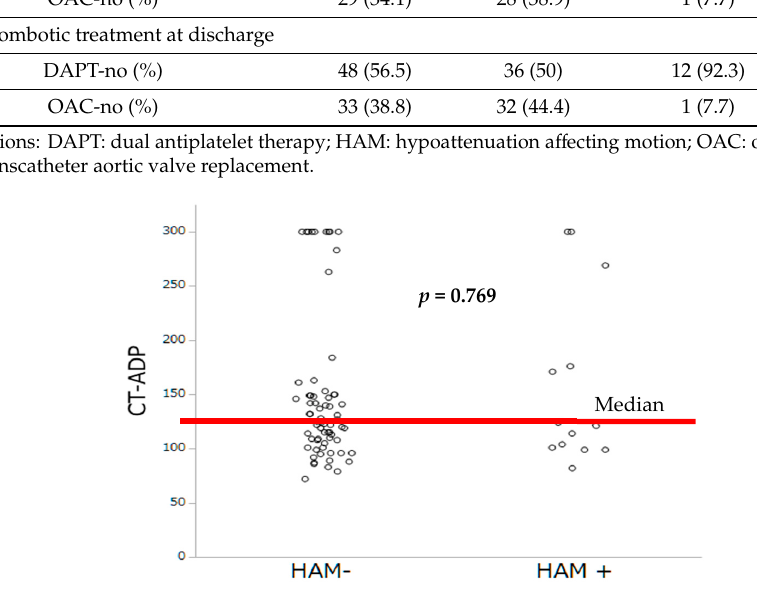
Figure 4. Platelet inhibition by PRI-VASP according to the occurrence of HAM